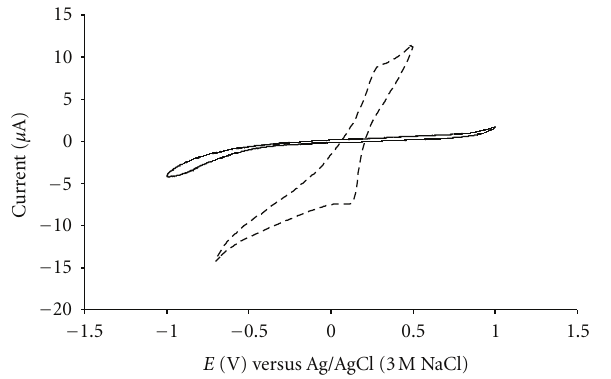
Figure 5: Cyclic voltammetric curves measured on the unmodified SCNR paste electrode (68% w/w SCNR and 32% w/w oil, solid line) and 20% (w/w) PB SCNR paste electrode (dashed line). v = 50mV/s, 0.1 M phosphate bu ff er (pH = 6.9).